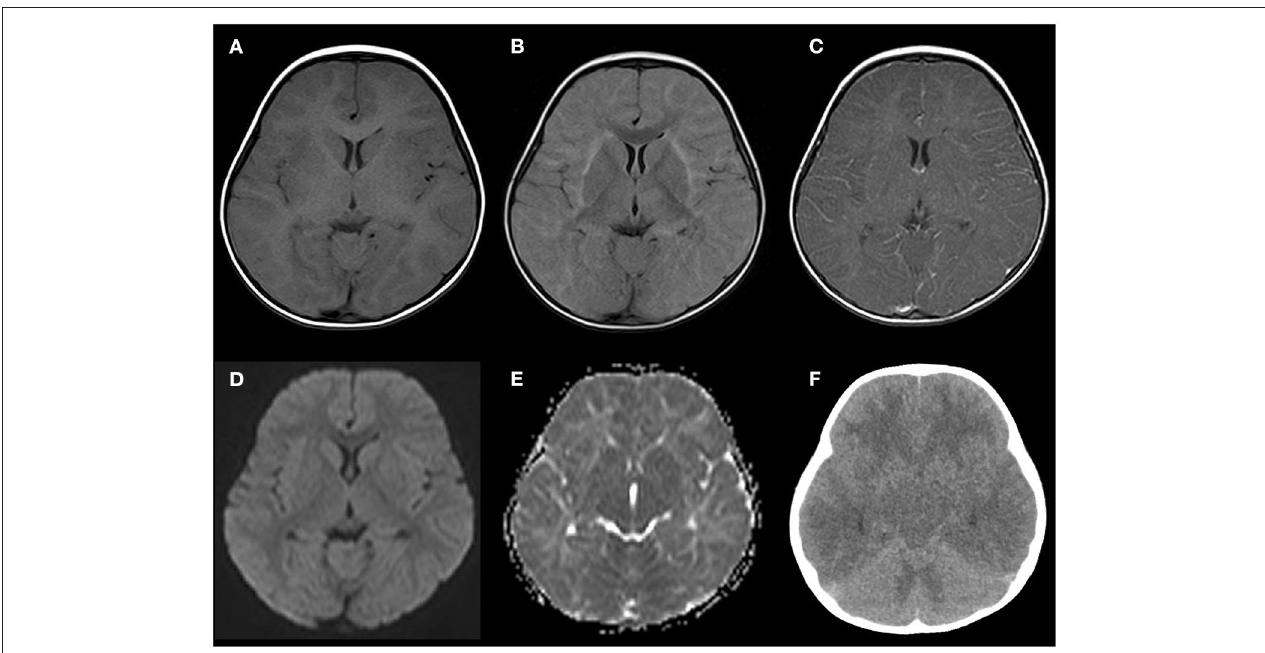
FIGURE 2 | Neuroimaging findings on days 13–14. (A–E) Several sequences of the head MRI on day 13. (A) Isointense white matter lesions on a T1-weighted image (T1WI). (B) Fluid-attenuated inversion recovery image showing a high intensity in the subcortical white matter and external capsule. (C) Post-gadolinium T1WI showing no enhancement in the white matter or perivascular lesions. (D) Diffusion-weighted imaging showing isointense signals in the white matter lesions. (E) An apparent diffusion coefficient map showing diffuse hyperintensity in the white matter. (F) Brain computed tomography (CT) performed 8h after the MRI demonstrating cerebral and cerebellar edema with sulcal and cisternal